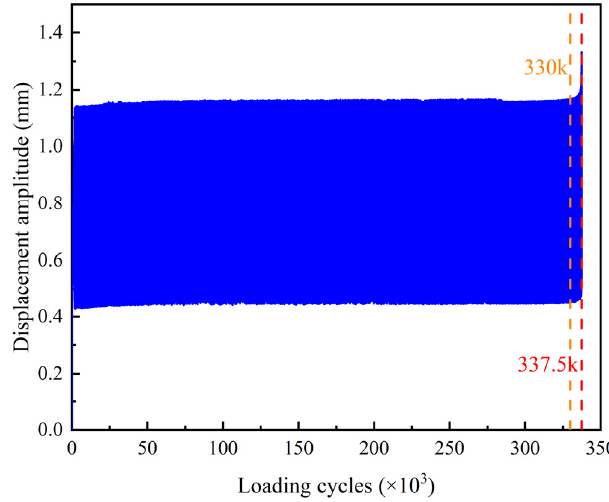
Figure 22. Displacement of upper clamp of test machine.